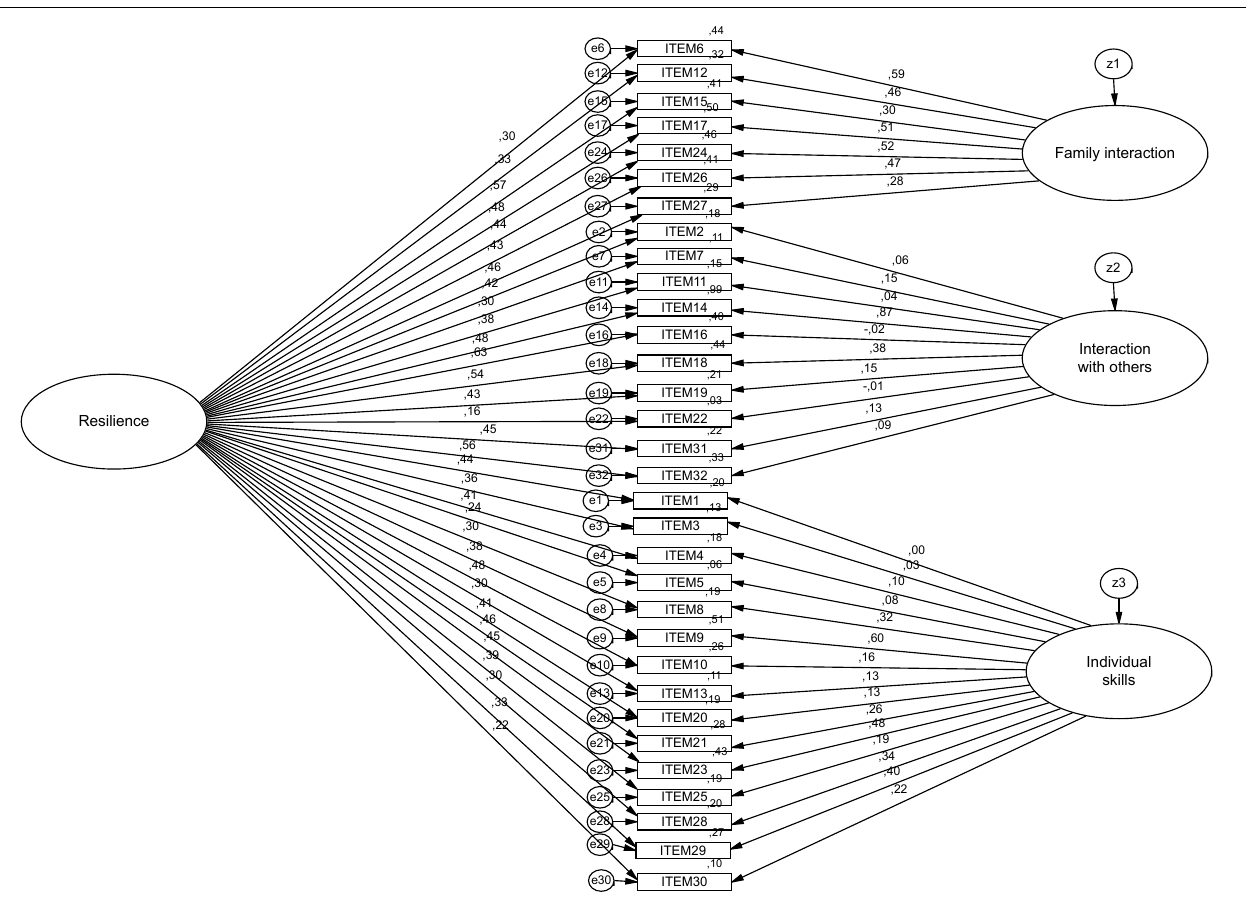
dimensions with four measures of mood, resilience, coping strategies, and self-concept were represented in Table 5 . The